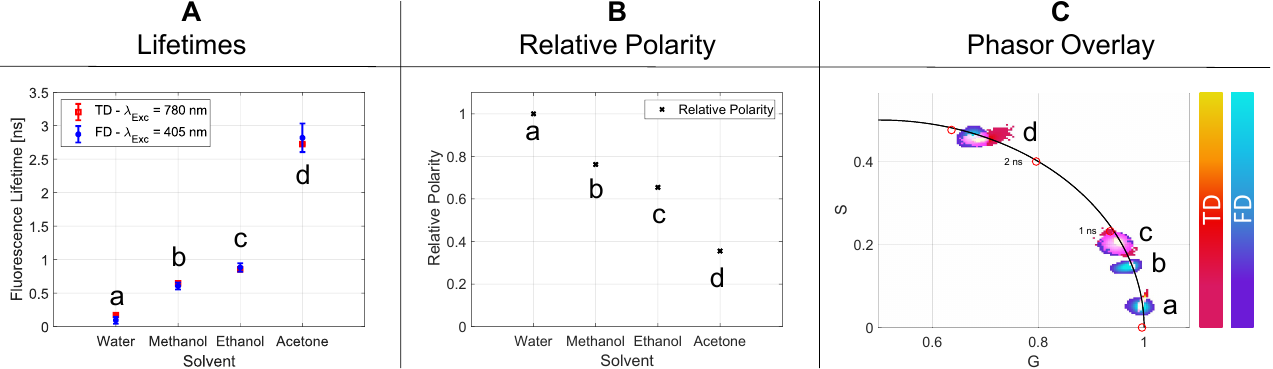
Figure 3. In section ( A ), the relative polarity of each individual solvent is illustrated. Compared to the obtained lifetimes in ( B ), an indirectly proportional behavior to the polarity is noticeable. Section ( C ) represents the overlayed phasor plots of the TD and FD